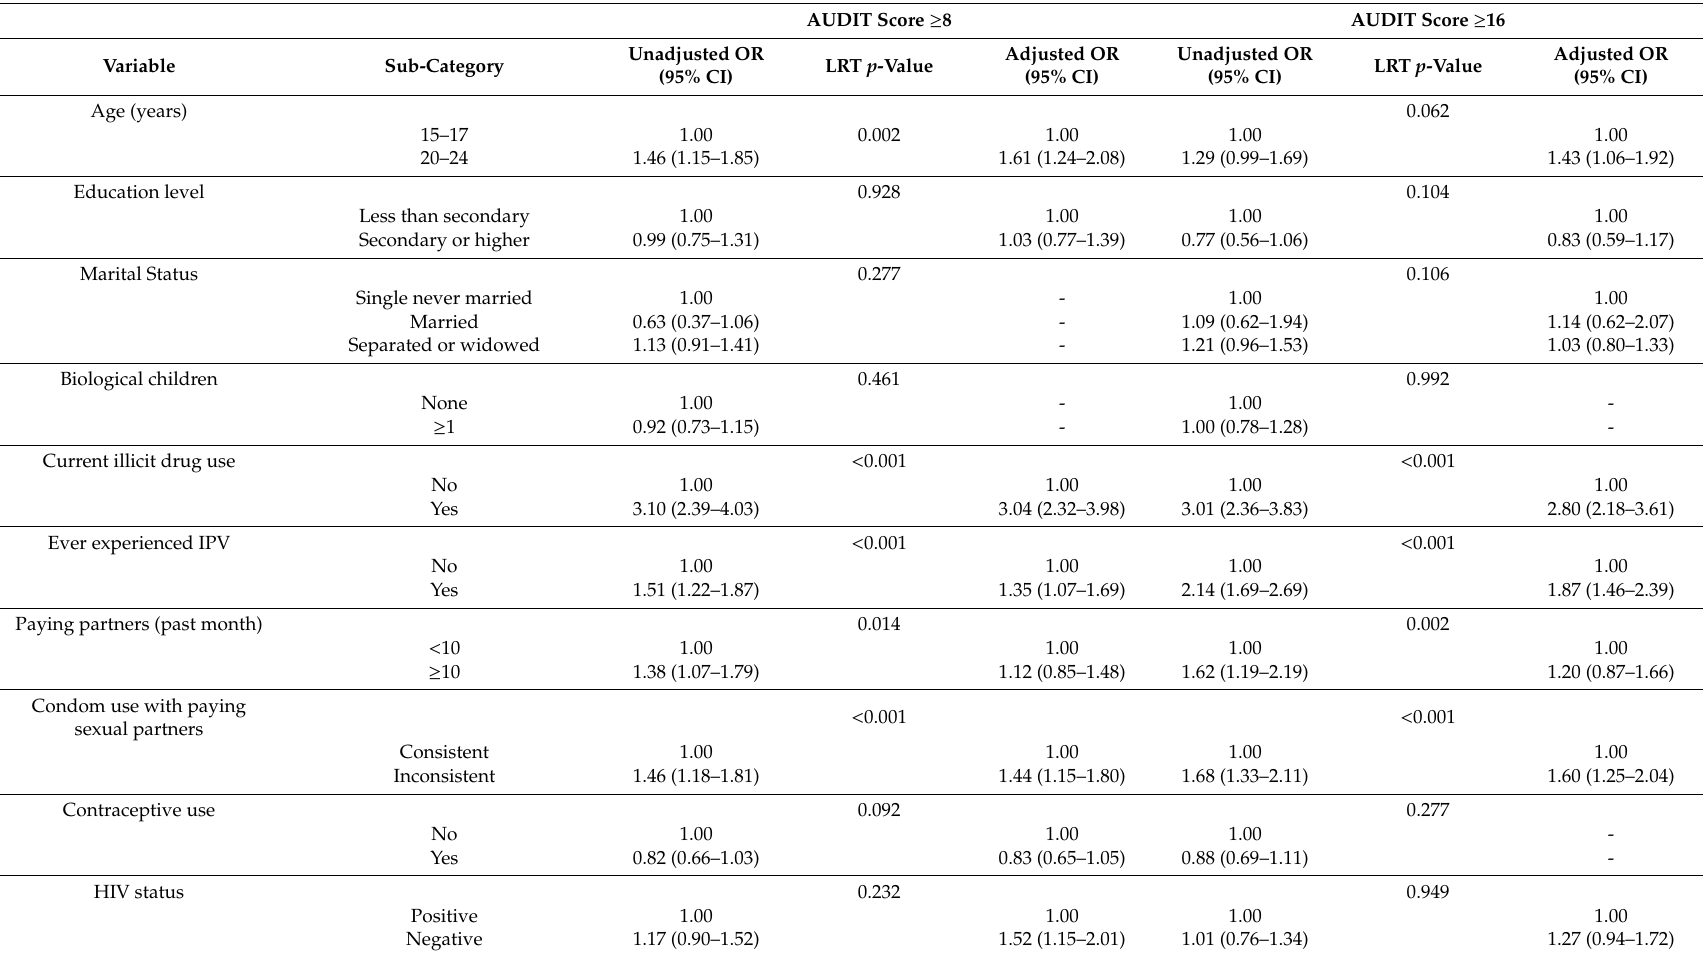
Table 4. Factors associated with Alcohol misuse among